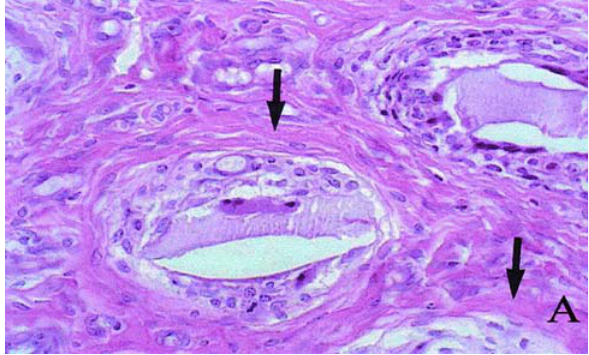
FIGURE 3- Photomicrography showing subcutaneous tissue response to xenogenic bone graft at 60 days post- implantation, specially the fibrosis (arrows) around the particles. Magnifications: x40, Hematoxylin and Eosin